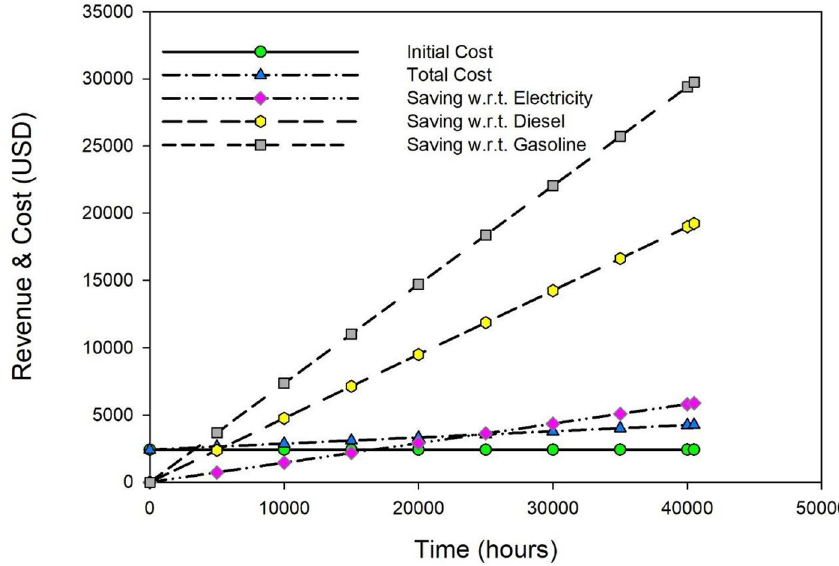
Figure 5. Break-even analysis for the yogurt processing unit in context with fuel saving.